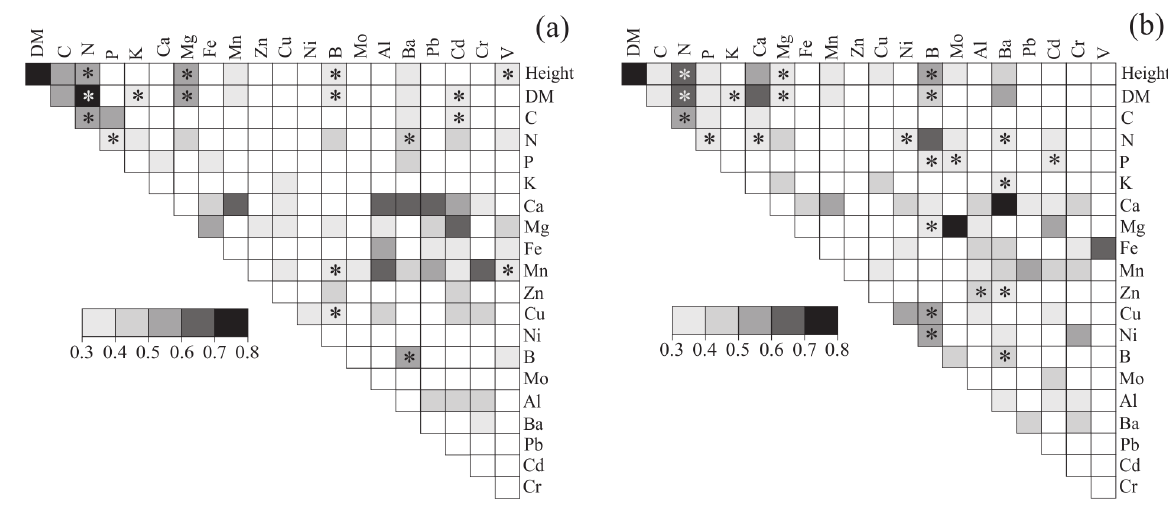
Figure 2 - Correlograms of growth attributes and elements in leaves of yerba mate clones ( a = Clone 1; b = 2 Clone). Where: DM = aerial part dry matter. Squares with colors indicate significant correlation (p<0.05), while white squares indicate that there were no significant correlations. Asterisks indicate negative